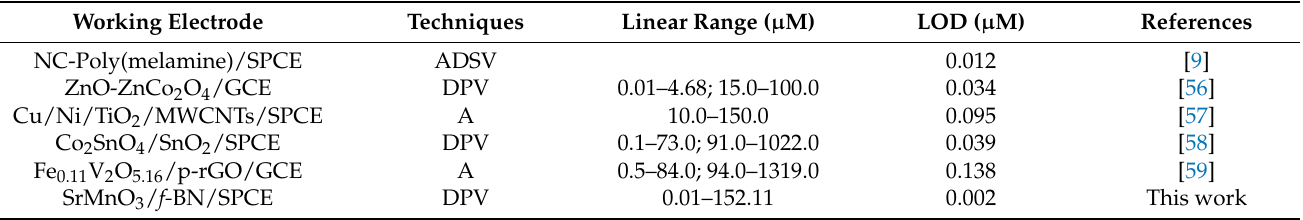
Figure 6. ( A ) DPV cathodic current response of sequential addition of FLD (0.01–152.11 µM) in PBS (pH 7.0) and ( B ) the corresponding linear calibration plot of concentration of FLD (µM) vs. current (µA) for three replicative measurements ( n = 3). Table 1. Comparison of FLD sensors with different previously-reported modified